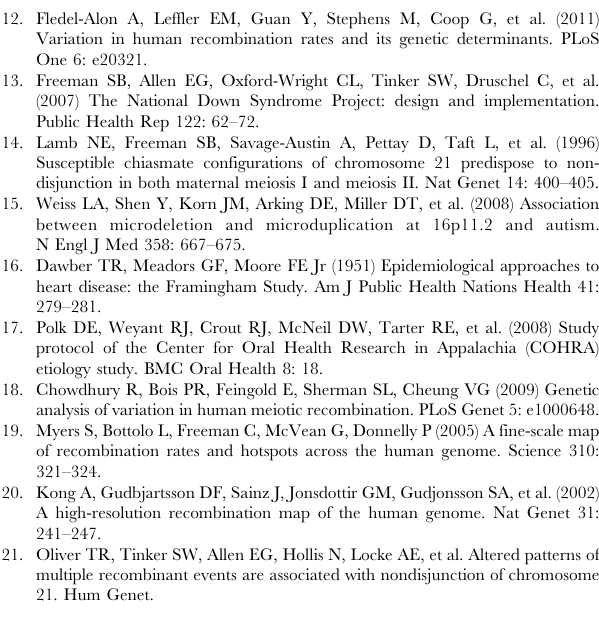
Figure S1 Distribution of Hotspots along 21q. Hotspot counts for each of the 66 bins across